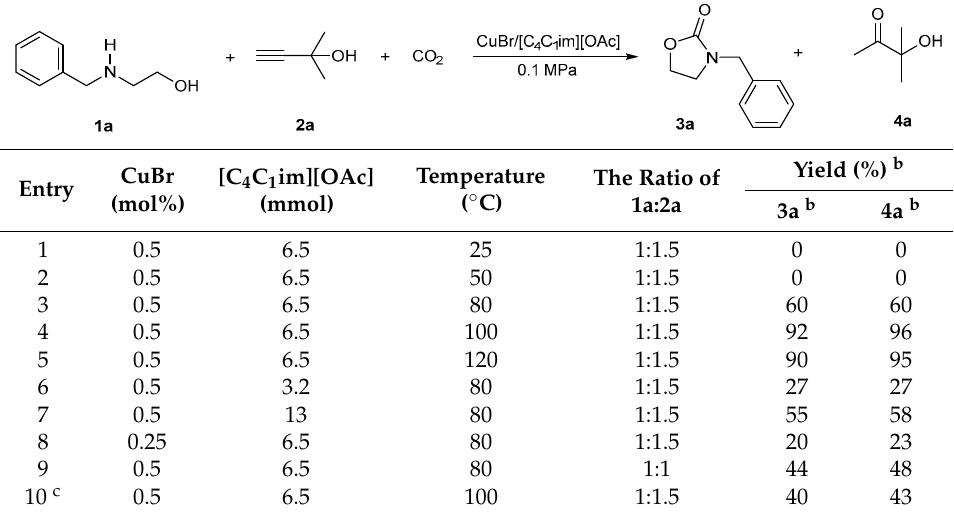
Table 2. Screen reaction conditions a .